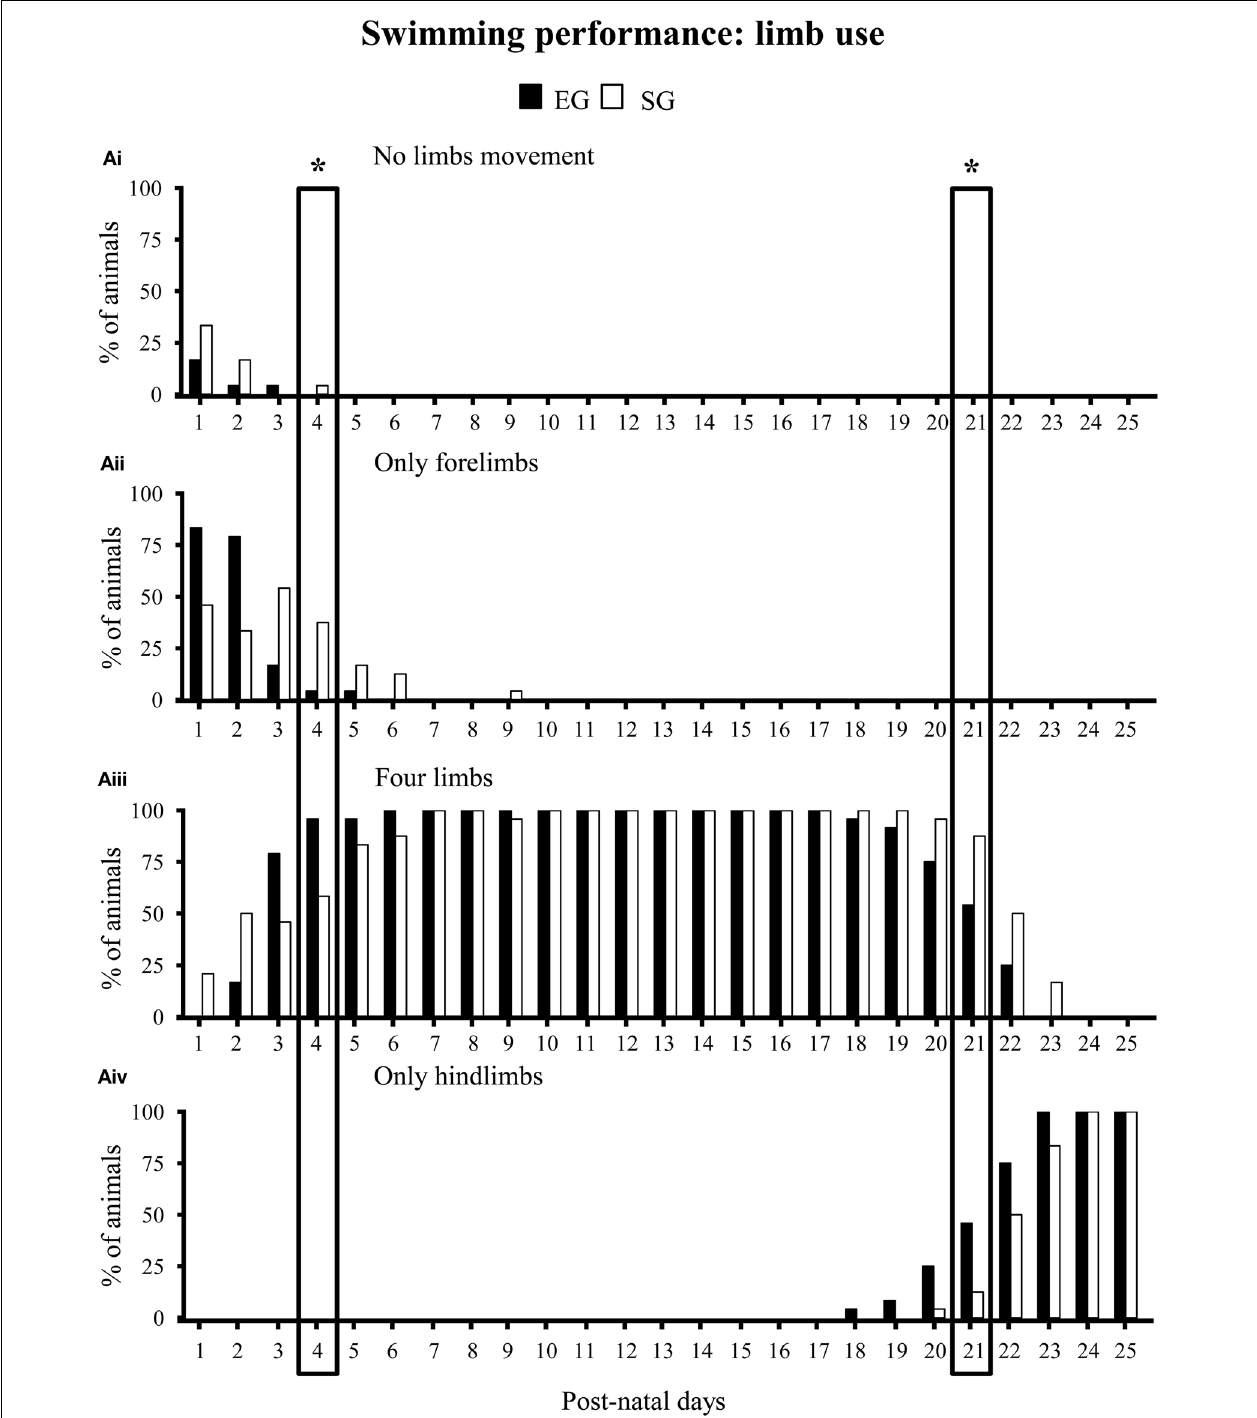
FIGURE 7 | Results of pre-reproductive maternal rearing condition on limb use during swimming. Histograms show percentages of EG ( N = 24) and SG ( N = 24) pups not paddling (Ai) , paddling with only forelimbs (Aii) , four limbs (Aiii) or only hindlimbs (Aiv) from pnd 1 to pnd 25 ( ∗ p < 0 . 01). The two boxes indicate that at pnd 4 and pnd 21 the score distribution relative to